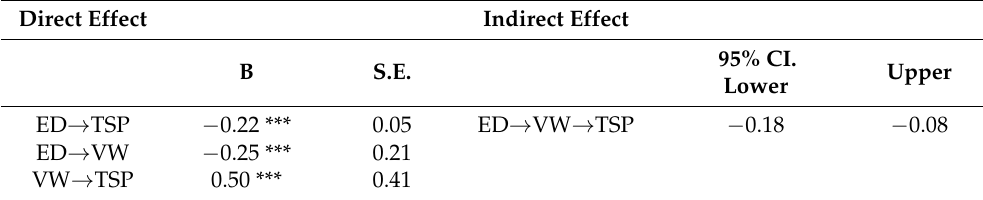
Table 4. Estimates and confidence intervals for the indirect effects of vitality at work.